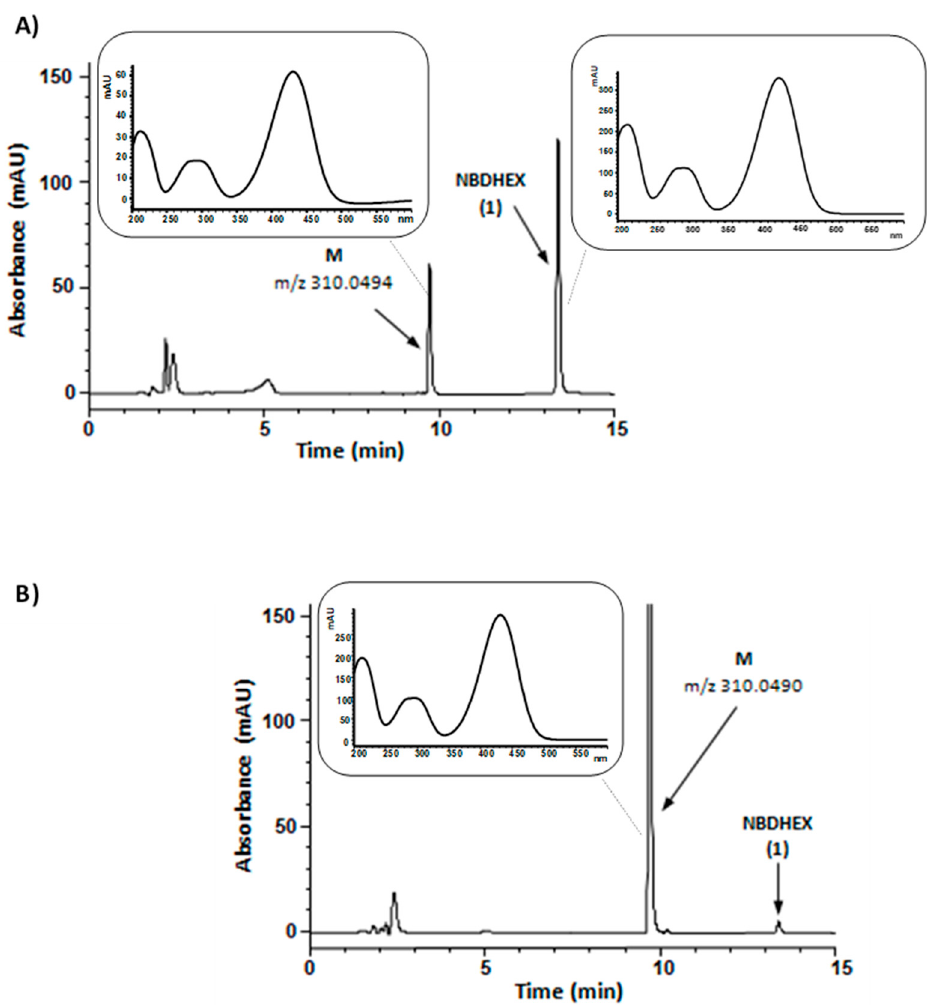
Figure 3. Representative HPLC chromatograms of reaction mixtures from a 60 min incubation (37 ◦ C) of NADPH-supplemented human liver microsomes (panel A ) or NAD-supplemented human liver cytosol (panel B ) with 50 µ M NBDHEX ( 1 ); in both mixtures, cofactor concentration was 0.5 mM. The samples were processed and analyzed by HPLC-DAD as described in Materials and Methods. In panel A chromatogram, percent areas of peaks M and NBDHEX (in terms of total peak area of the chromatogram) were 23 and 50, respectively; in panel B chromatogram, percent areas of peaks M and NBDHEX were 86 and 1, respectively. Panel A inset, UV-visible spectra of peak M and peak NBDHEX in the liver microsomes-containing mixture chromatogram. Panel B inset, UV-visible spectrum of peak M in the liver cytosol-containing mixture chromatogram. The reported m / z values were obtained from the ESI-mass spectra of collected peaks shown in Supplementary Figure S2 and refer to [M − H] − ion.